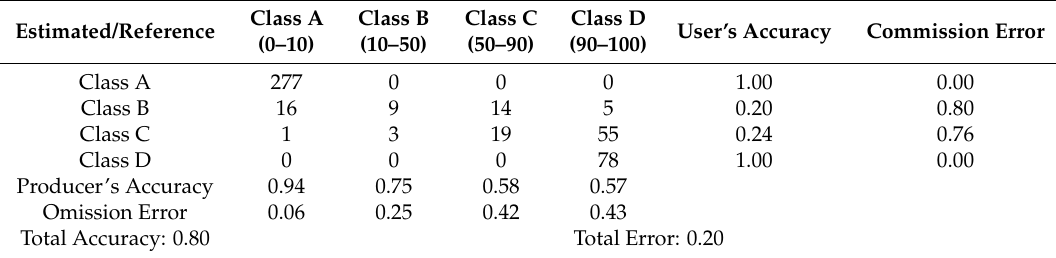
Table 5. Confusion matrices for Kenttärova canopy camera.